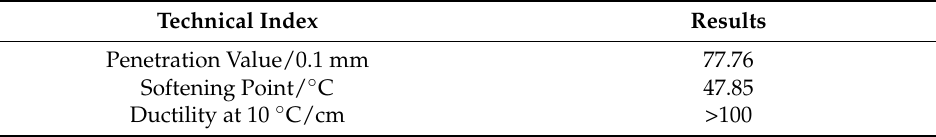
Table 1. Basic index of raw asphalt binder.